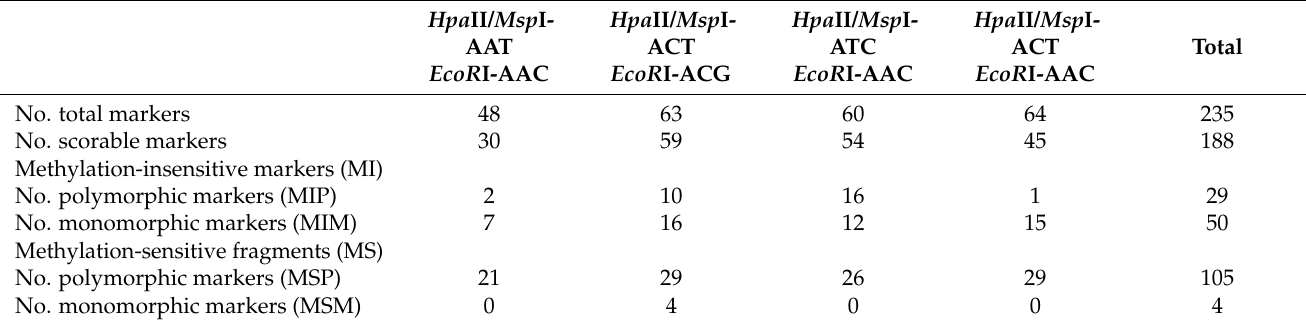
Figure 3. Predawn ( top ) and midday ( bottom ) water potential measured in well-watered (WW) and Figure 3. Predawn (top) and midday (bottom) water potential measured in well-watered (WW) and water-stressed (WS) seedlings from Spanish (ES) and Swedish (SE) provenances. water-stressed (WS) seedlings from Spanish (ES) and Swedish (SE) provenances. Table 6. Number of MSAPs detected with the primer combinations used to analyze seedlings from Spanish (ES) and Swedish (SE) Fagus sylvatica provenances subjected to different hydric